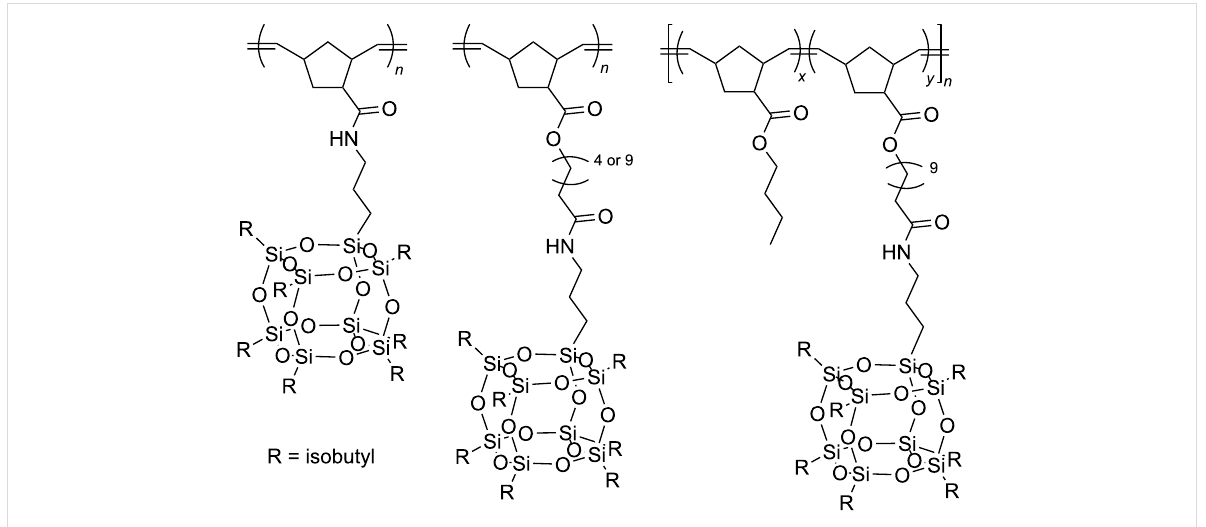
Figure 6: Homopolymers and copolymers having POSS groups attached to the main chain via flexible spacers of different lengths.